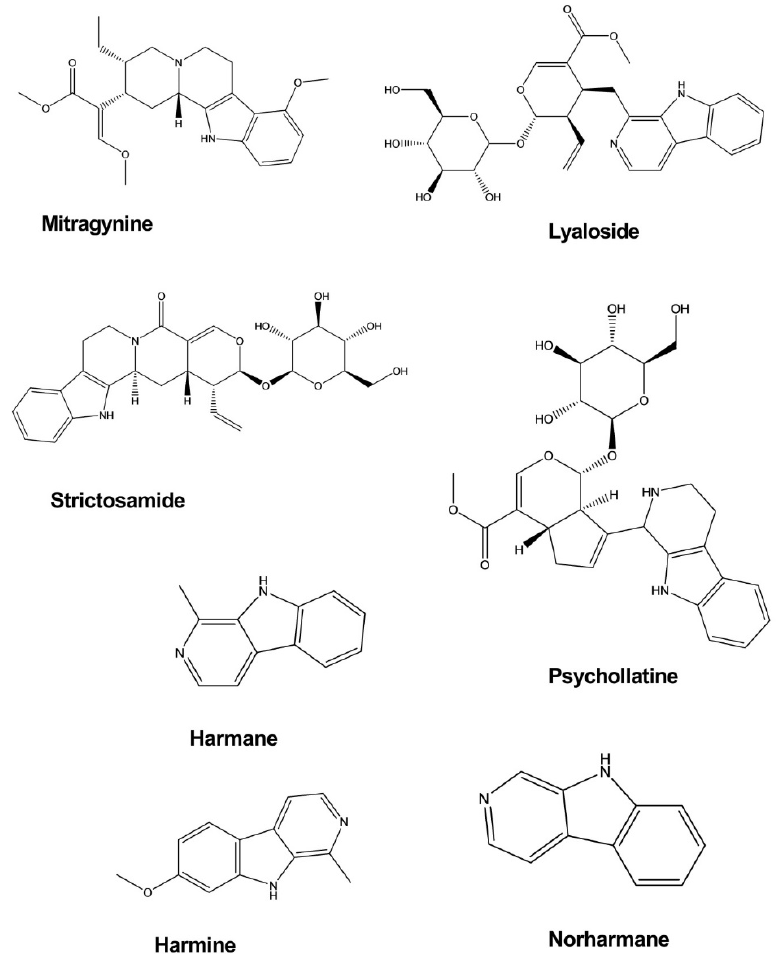
Figure 4. Antidepressant activity of indole